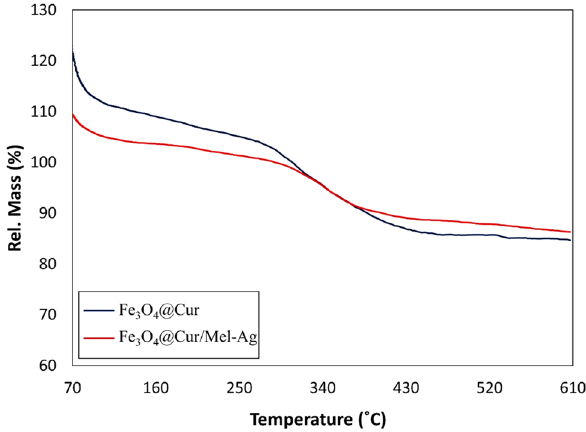
Figure 3. Weight loss versus temperature TGA curves of Fe 3 O 4 @Cur nanopowder and Fe 3 O 4 @Cur/Mel-Ag magnetic nanocomposite, heated up to 610 °C in air.